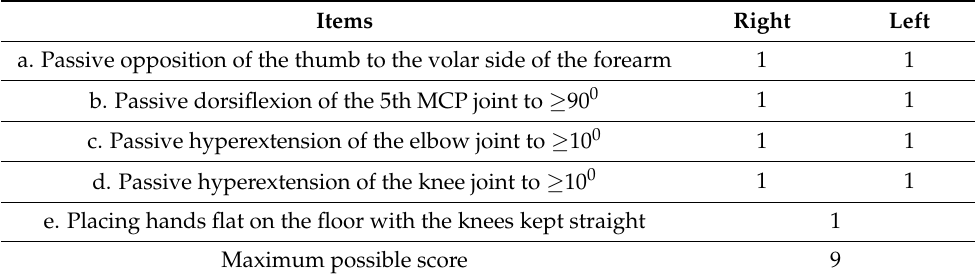
Table 1. Beighton scoring system.